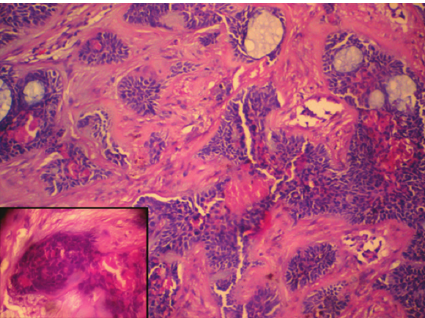
Figure 3: Cell nests, horn plugs, immature germ cells, and follicular papillae, surrounded by fibrotic and hyalinized stroma (HE 100X). Inset shows high power view of follicular papillae (HE